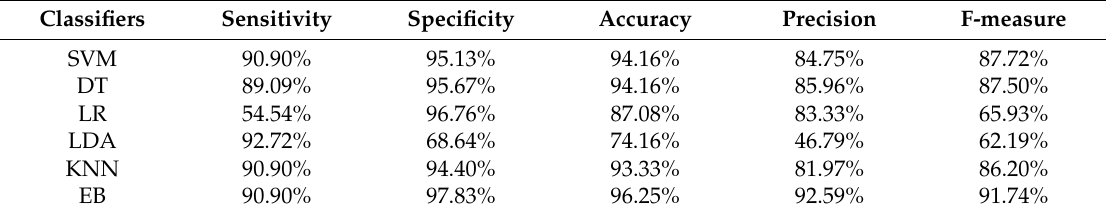
Table 5. Classification results based on particle swarm optimization coupling with different classifiers.